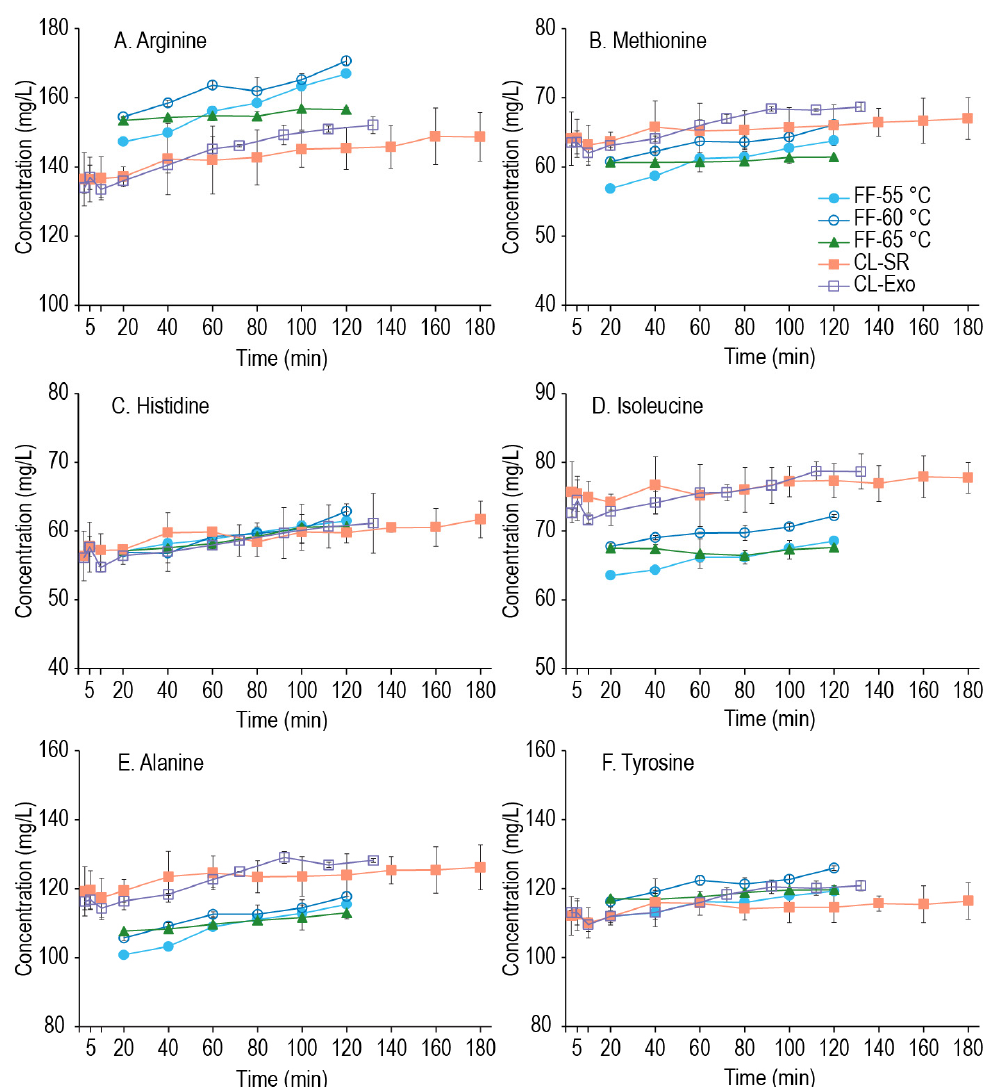
Figure 3. Time-dependent concentrations of two amino acids from each utilization group. Group A: ( A ) Arginine, ( B ) Methionine; Group B: ( C ) Histidine, ( D ) Isoleucine; and Group C: ( E ) Alanine, ( F ) Tyrosine from the malted millet worts described in Section 2.4. Time 0 min refers to the start of the second mash, upon recombination of the enzyme extract and the cooled gelatinized starch, and all samples are at a liquor-to-grist ratio of 4:1.